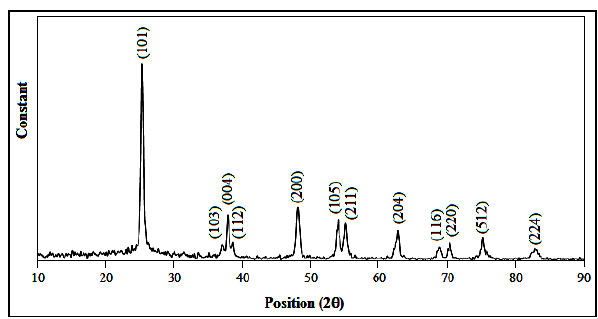
Fig. 1. The X-ray diffraction patterns of the nano TiO